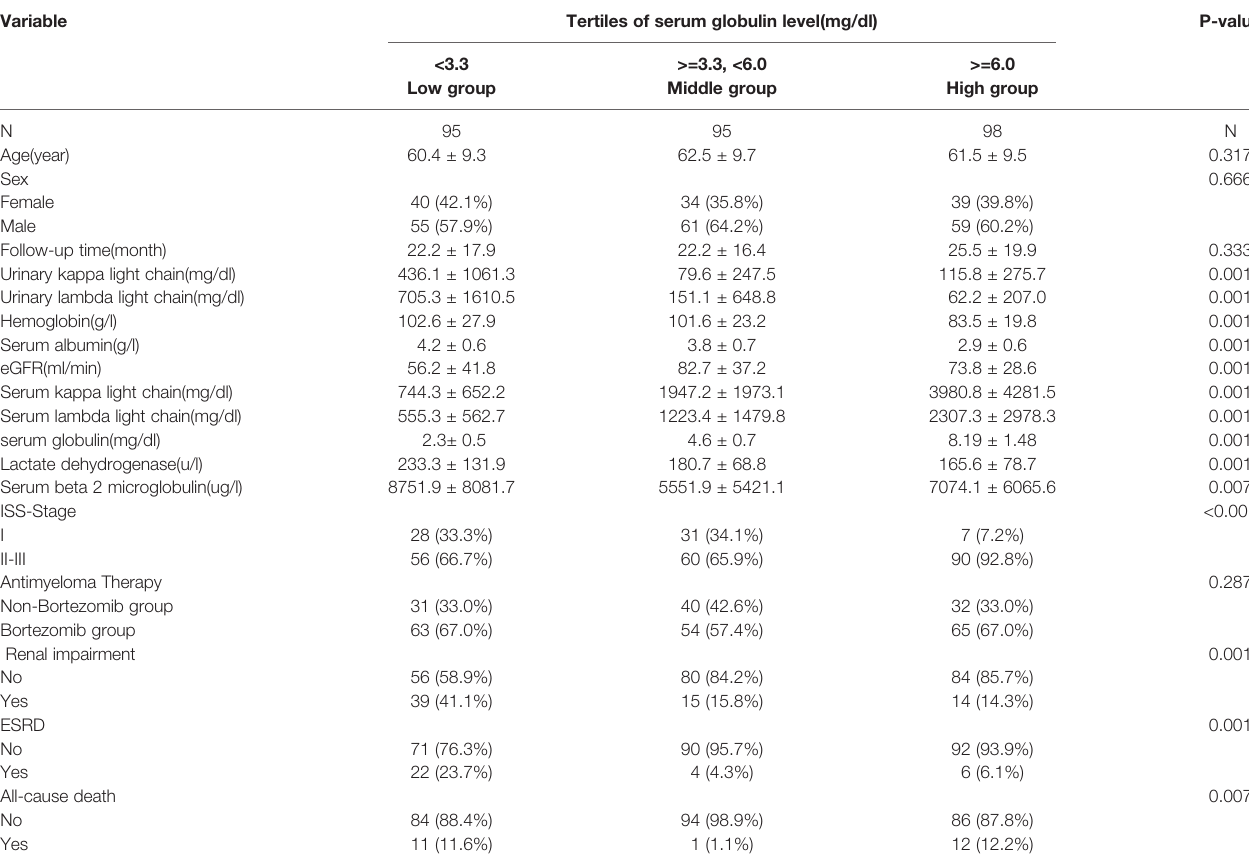
TABLE 1 | Baseline clinical and fifi ndings of the studied patients separated by tertiles of serum globulin level.